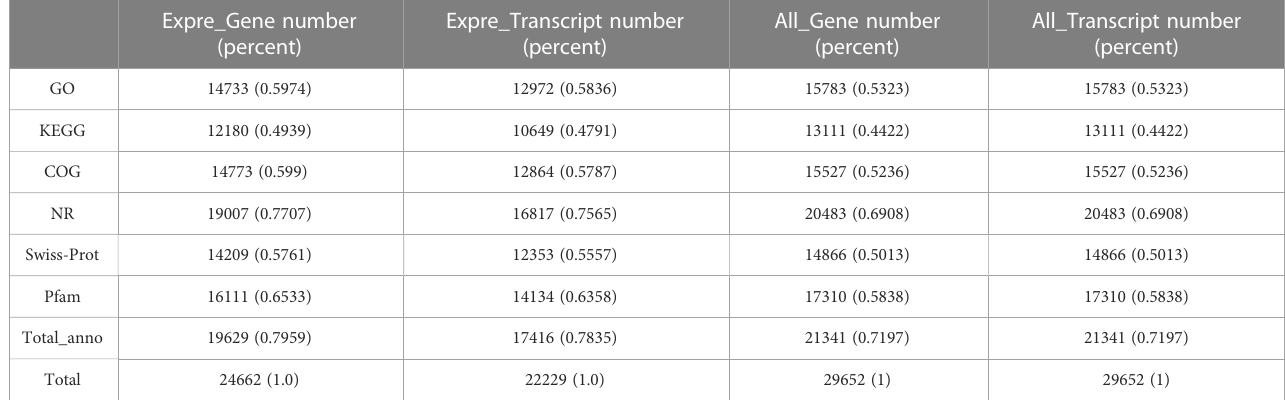
TABLE 2 Statistics of gene annotation.